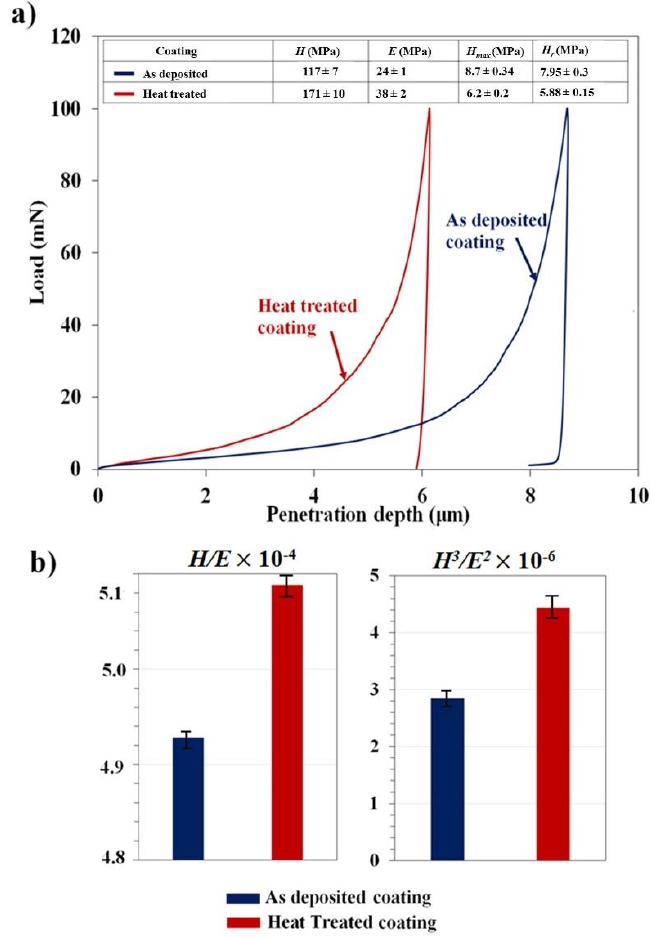
Figure 8. Nanoindentation results: ( a ) Load-Penetration depth curves and ( b ) the values of H / E and H 3 / E 2 indexes for as-deposited and heat-treated coating.